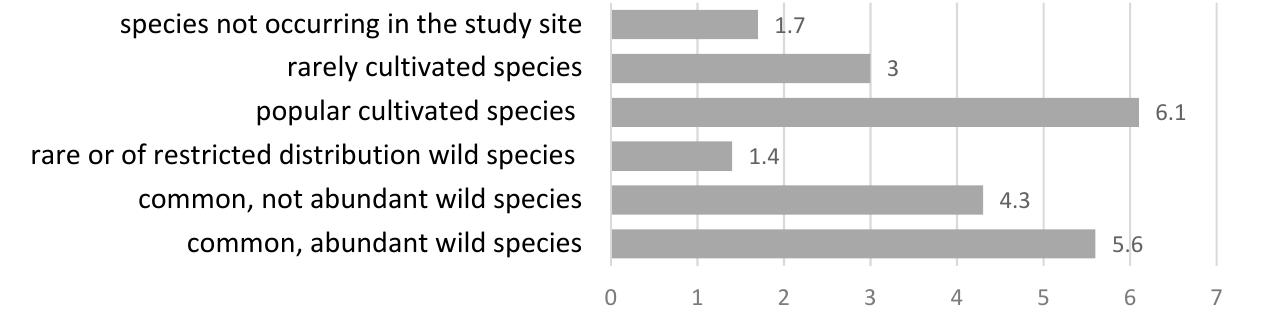
Figure 1. Mean use report of number per species in plant species frequency categories.